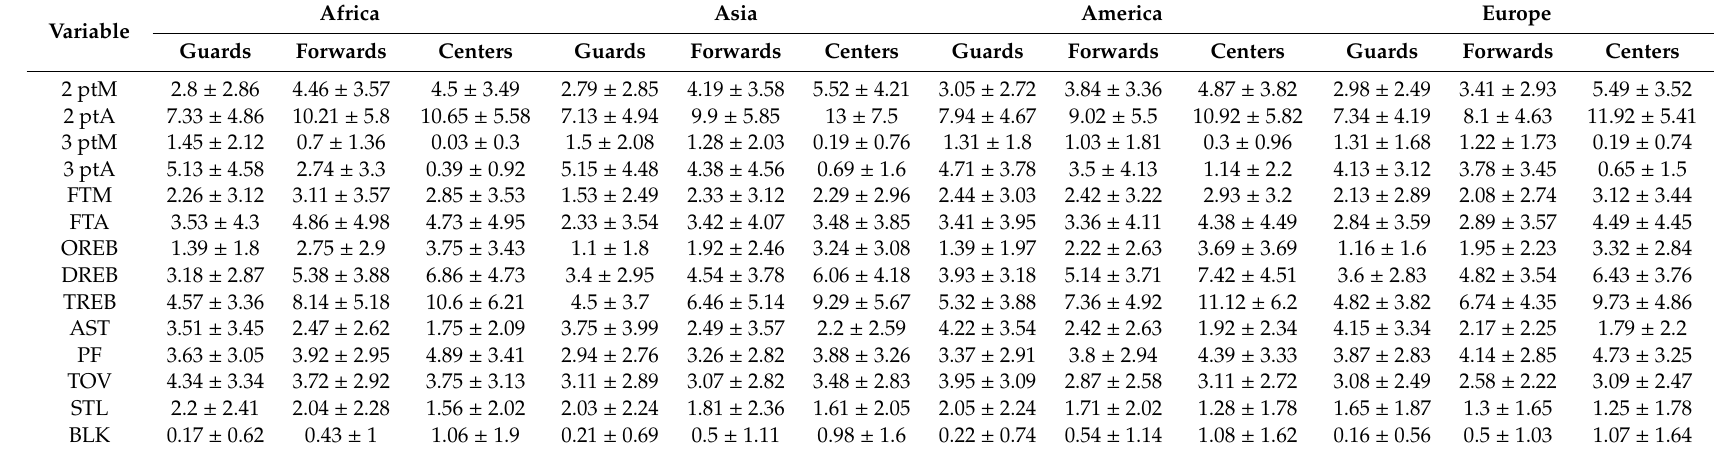
Table 2. Descriptive statistics of technical performances considering playing positions among four continental